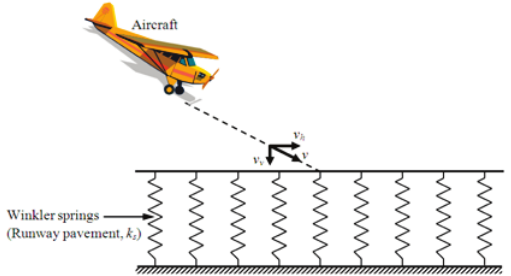
Fig. 7. Landing stage of an aircraft on an idealised runway pavement (adopted from Yadav, Shukla